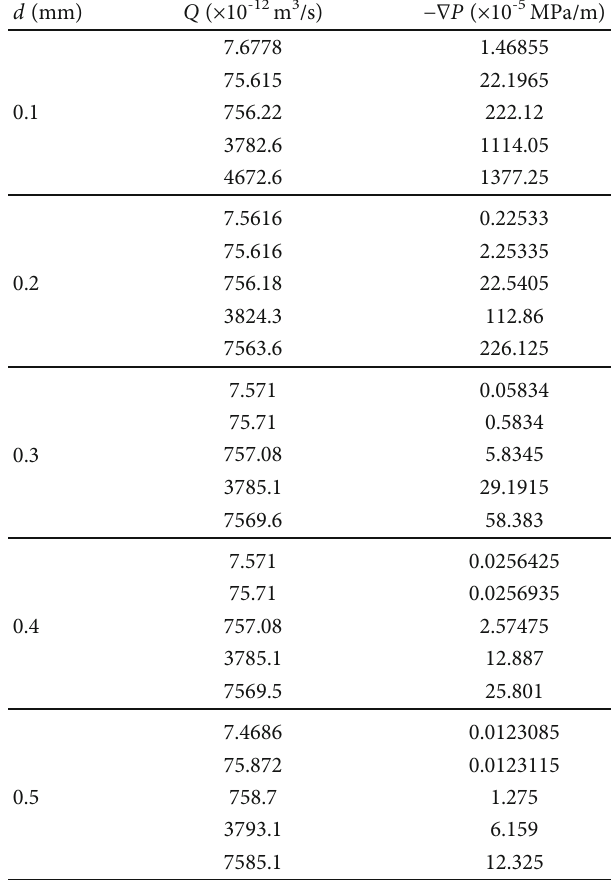
Table 2: Percolation result diagram of the rough fracture model. d (mm) Q ( × 10 -12 m 3